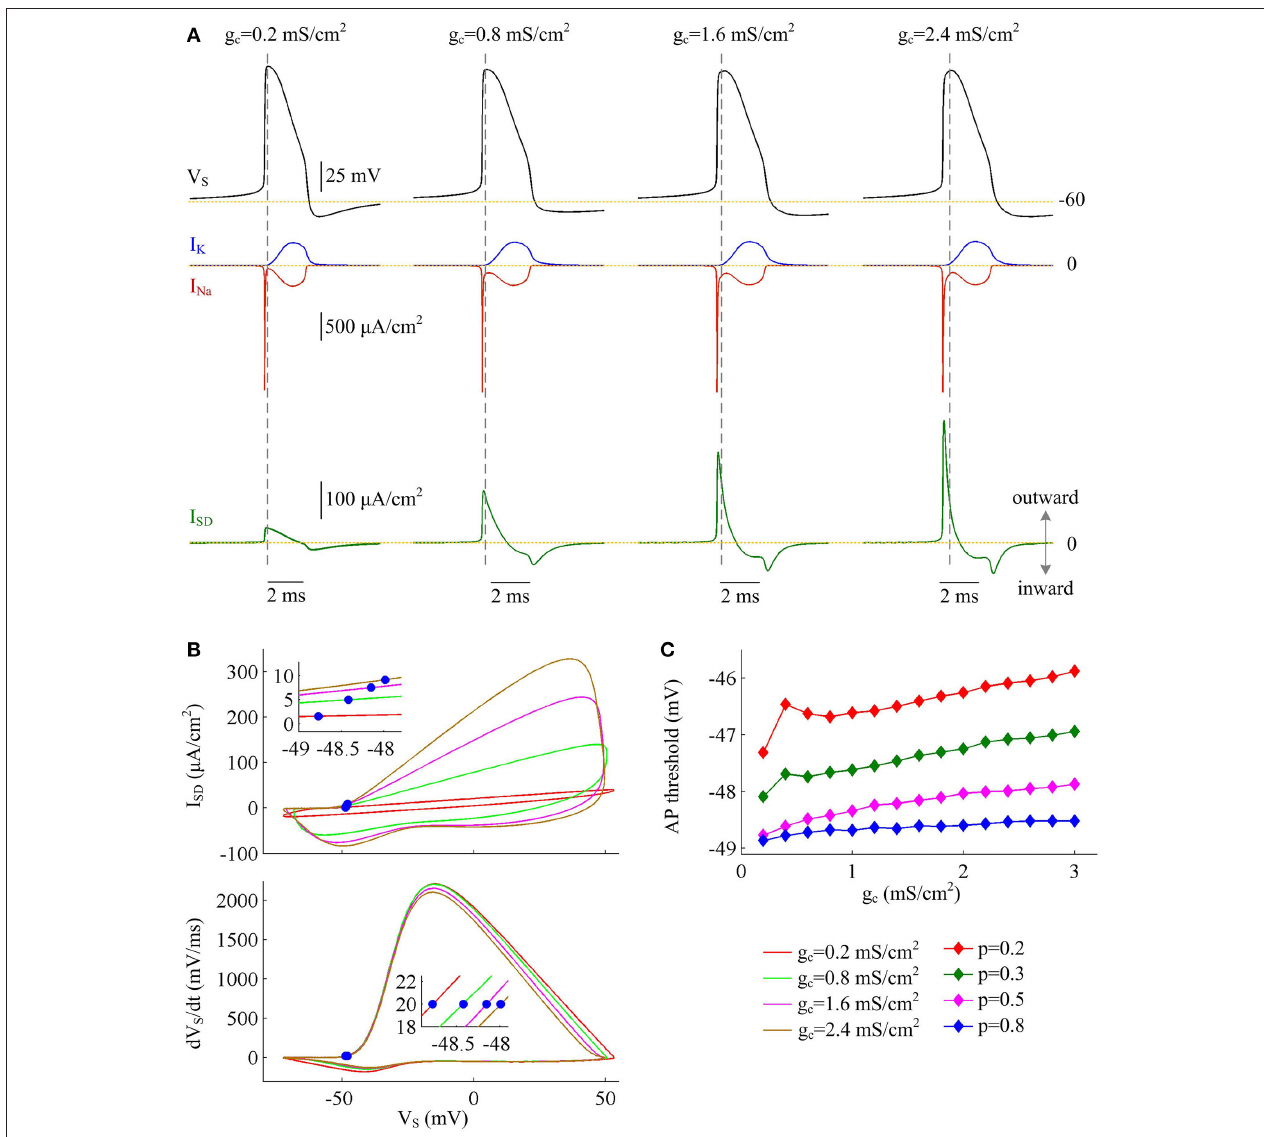
FIGURE 5 | Inefficient APs arise from increased overlap between I SD and I Na as coupling conductance increases. (A) I Na (red), I K (blue), and I SD (green) underlying the APs with different values of coupling conductance, which have been indicated on the top of the panels. Morphological parameter is p = 0.5. (B) Top panel depicts I SD - V S curve for each AP shown in (A) . Bottom panel is the phase plot of d V S /d t vs. V S for corresponding AP. Blue dots indicate where APs are initiated. (C) AP threshold is plotted as a function of g c with different values of p . Dendritic input is I D = 2 µ A / cm 2